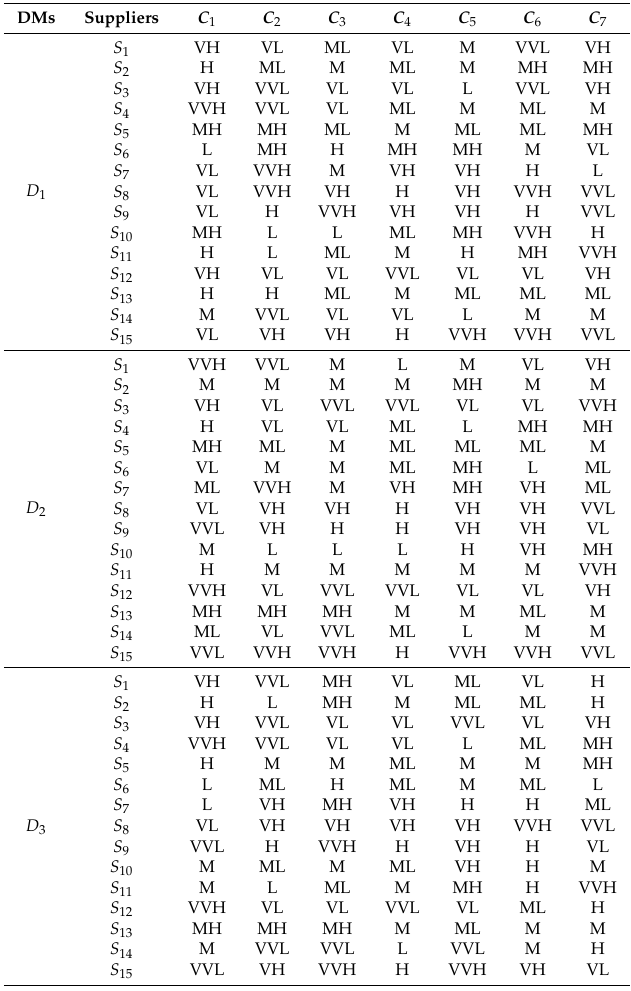
Table 4. The evaluations of the suppliers by each